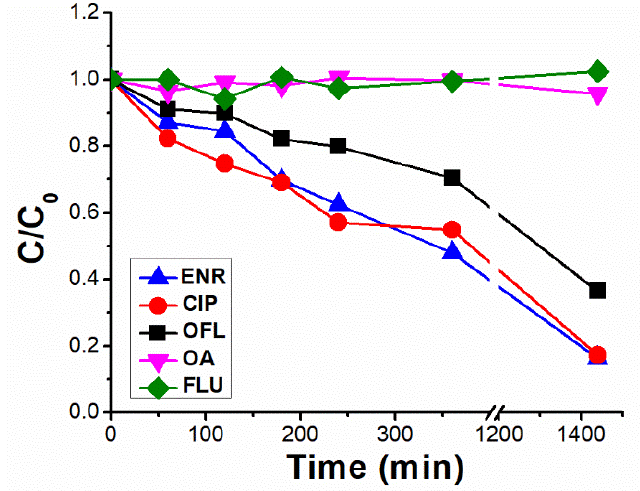
Figure 2. Normalised photolytic degradation under UVA irradiation of enrofloxacin (ENR), ciprofloxacin (CIP), ofloxacin (OFL), oxolinic acid (OA) and flumequine (FLU) individual solutions, each with an initial concentration of 12.5 µM, spiked in ultra-pure water at pH = 7.5.